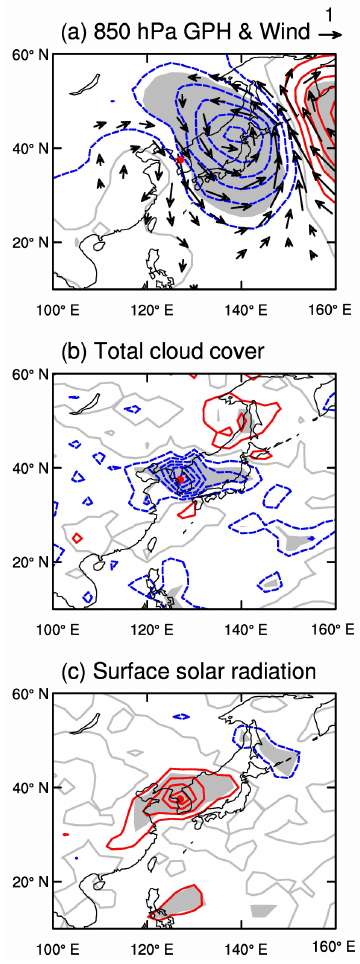
Figure 4. Composites of seasonal anomalies of (a) geopotential height (contours with interval of 2.5gpm) and wind (arrows with reference scale of 1ms − 1 ) at 850hPa, (b) total cloud cover frac- tion (contours with interval of 2%), (c) downward solar radiation anomaly at the surface (contours with interval of 5Wm − 2 ) for each (cid:1) exceeds the sum of the mean and 1 stan- first day that exp (cid:0) O 38h ST dard deviation. Total number of events, mean, and standard devia- tion is 346, 1, and 0.41, respectively. Geopotential height and wind, total cloud cover, and downward solar radiation statistically signifi- cant at the 95% confidence level are represented by light gray shad- ing and arrows. Location of Seoul is marked by a solid red